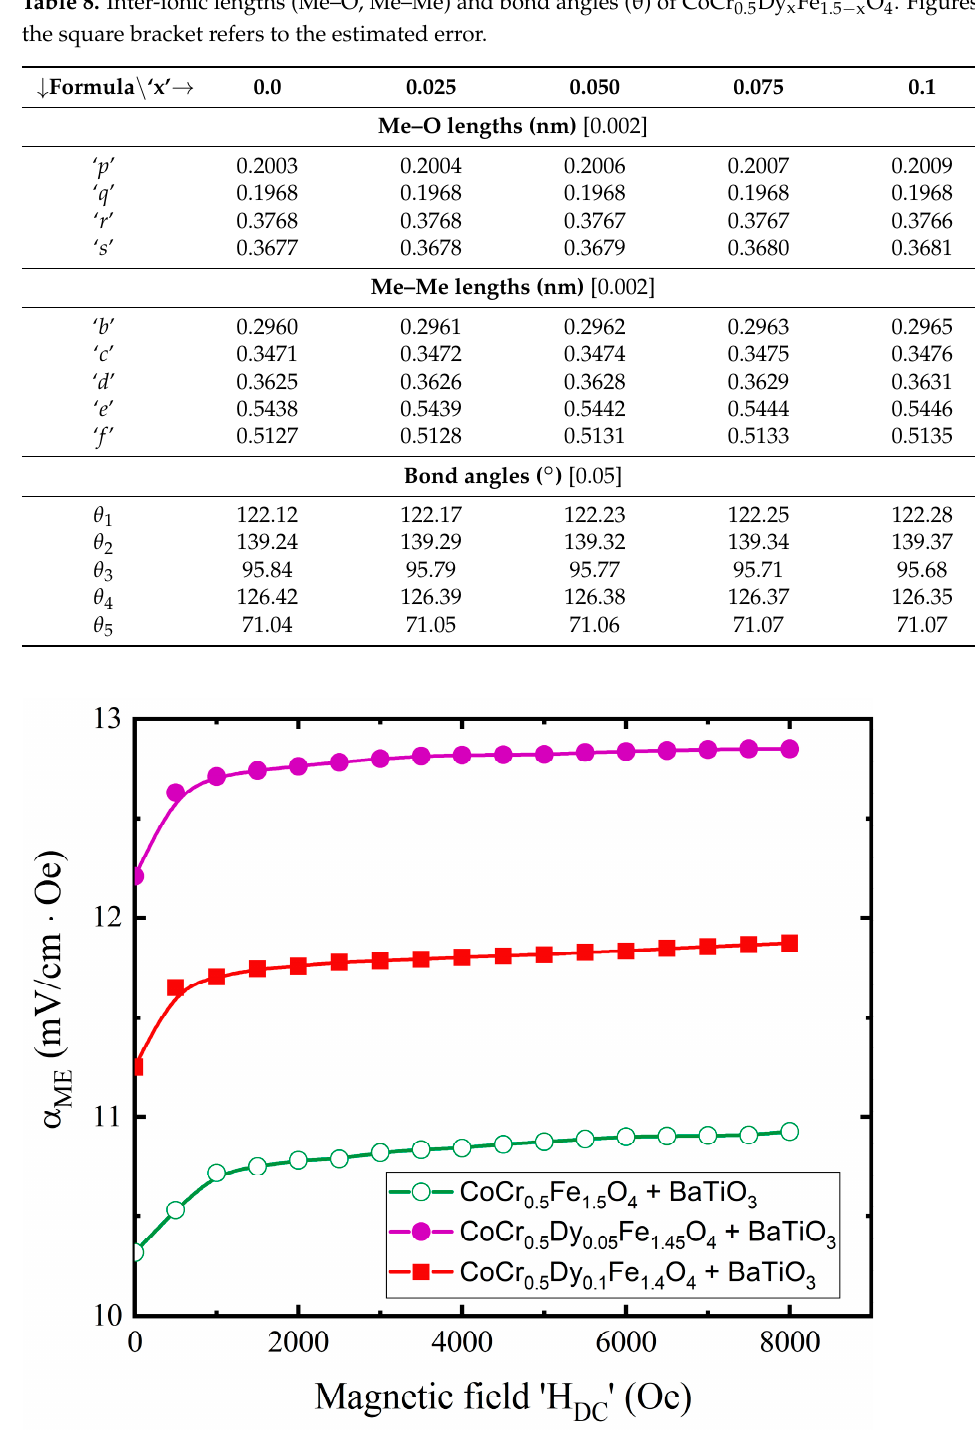
Figure 12. Variation of magnetoelectric voltage coefficient ( α ME ) with DC magnetic field ( H DC ) for three compositions of ferrite + BaTiO 3 nanocomposites.